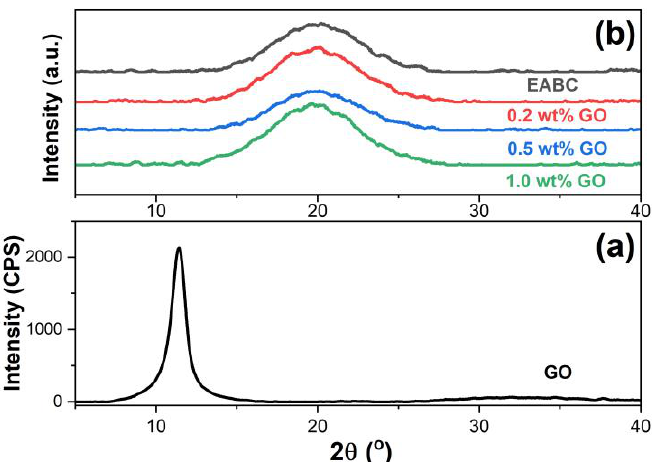
Figure 4. XRD patterns of pristine GO ( a ) and the unmodified and GO-modified EABCs ( b